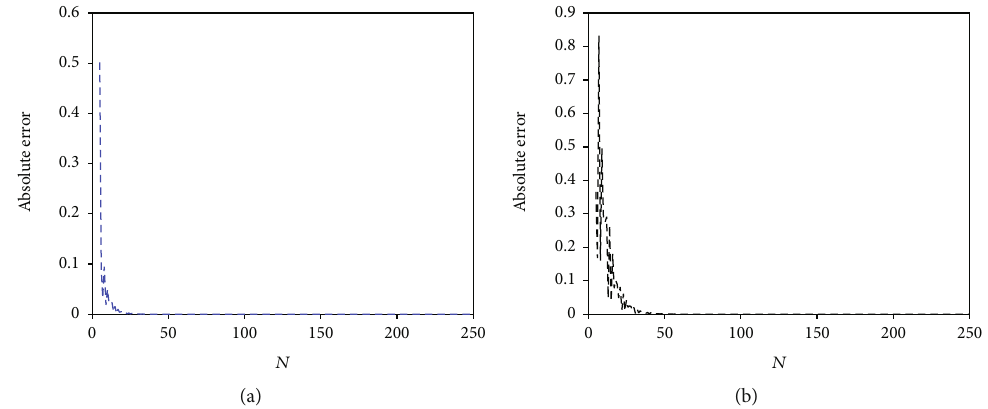
Figure 11: In (a), the plot shows various nodes N along Γ and β = 1 the error function of ζ shows various nodes N along Γ and β = 1 the error function of ζ